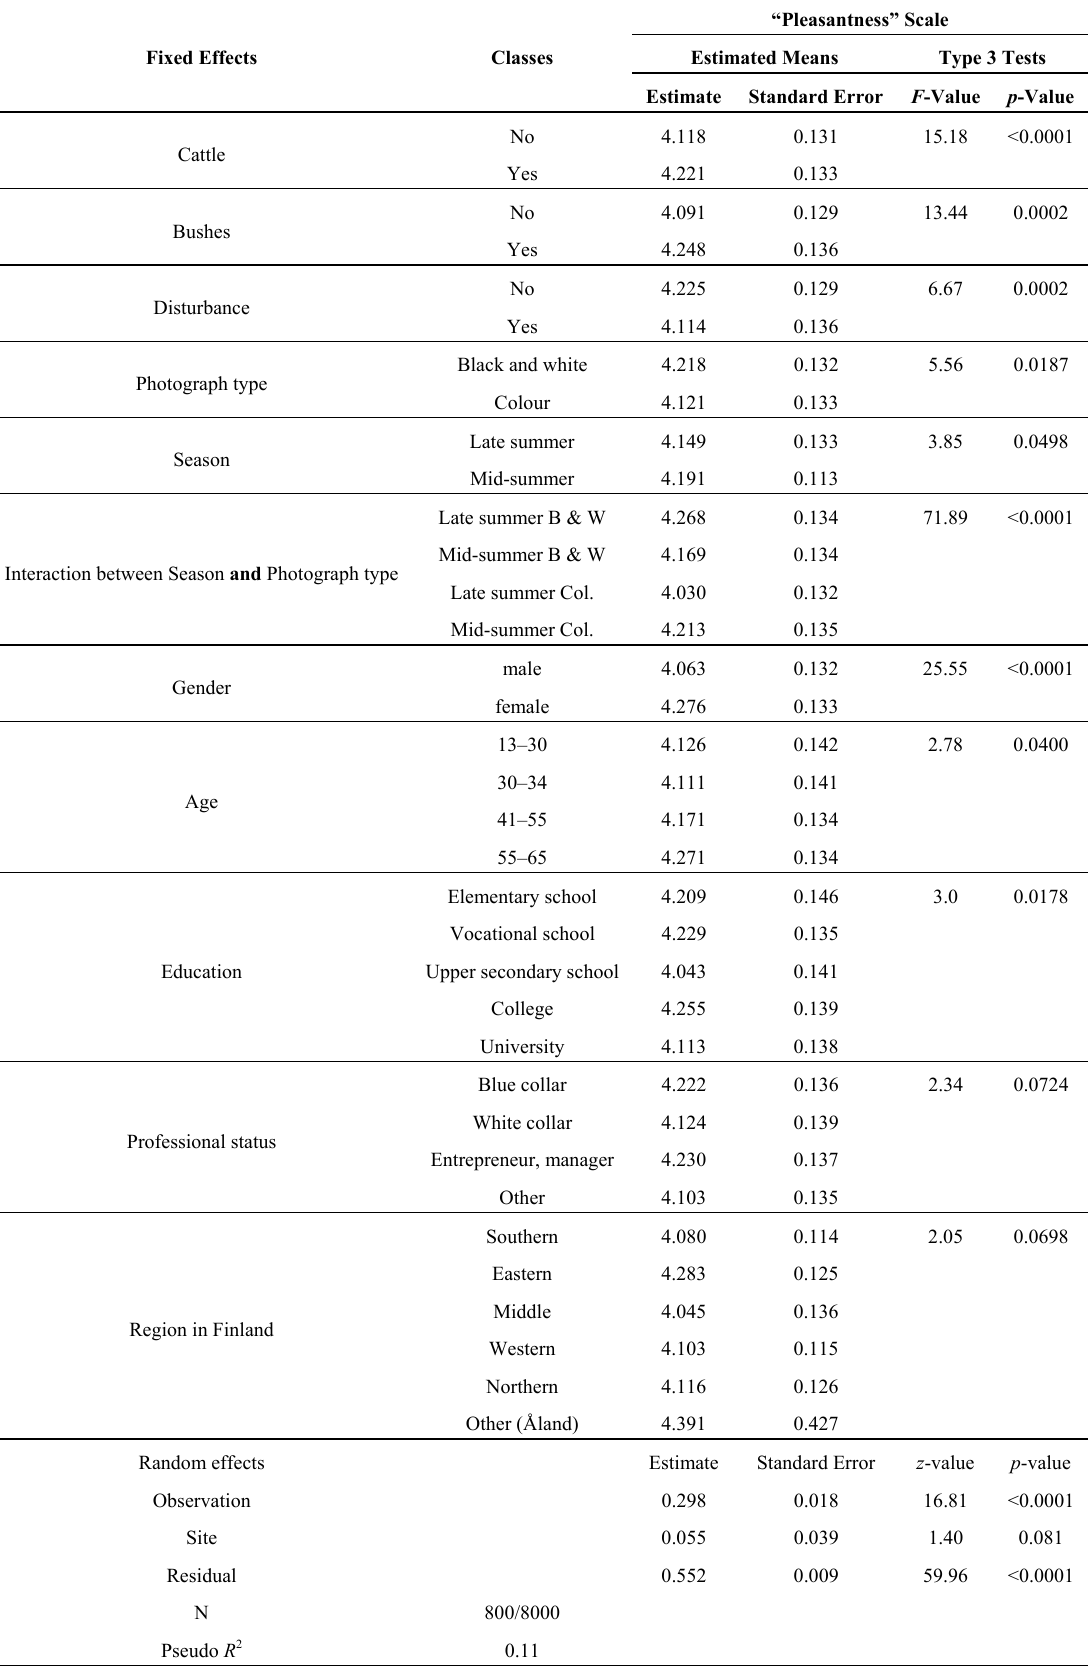
Table 3. Linear mixed model results for the “pleasantness” scale of landscape